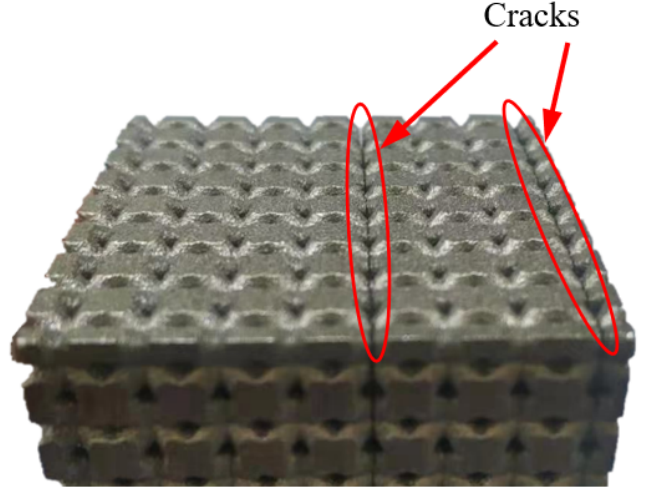
(cid:3031)(cid:3046)(cid:4593) = 0.7